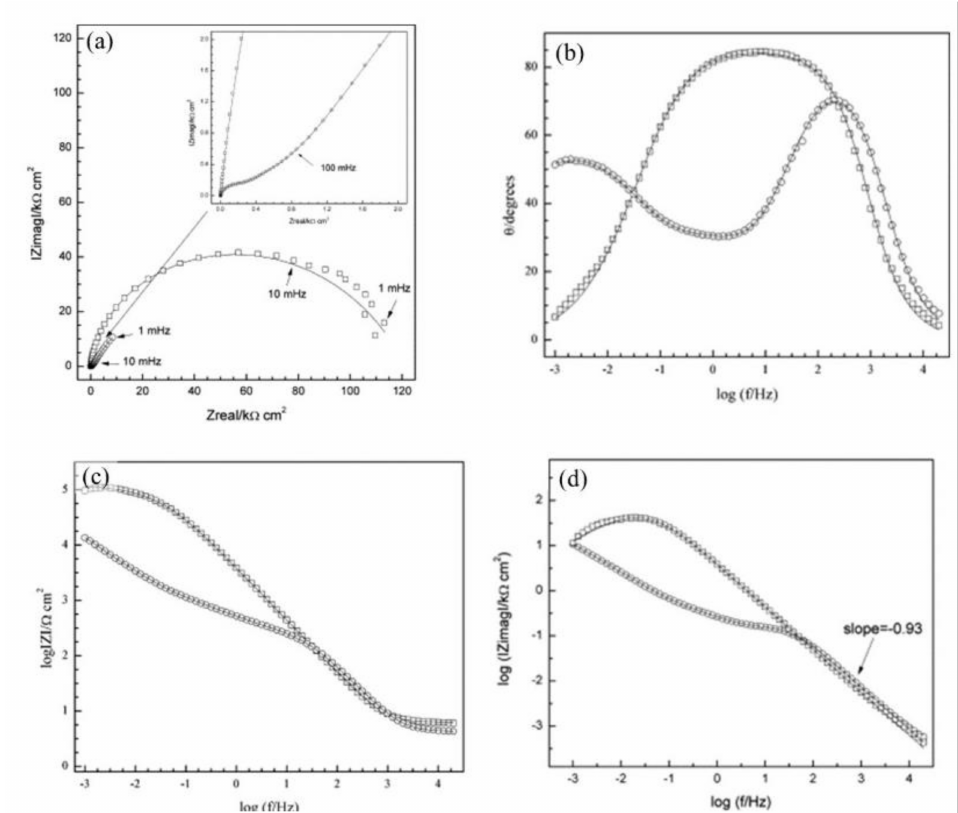
Figure 9. Impedance spectra recorded on steel electrodes aged over 24 h at E corr in SSP + Cl − with and without inhibitor. The symbols represent the data and the lines the fitting results. ( a ) Nyquist representation, ( b ) and ( c ) Bode representation, and ( d ) imaginary part of impedance as function of frequency, in logarithmic scale. PSS + Cl − (– (cid:3) –), PSS + Cl − + PO 43 − (– –) [60]. Reproduced with permission from Yohai, L. et al., Electrochim. Acta; Published by Elsevier, 2013. (cid:35)